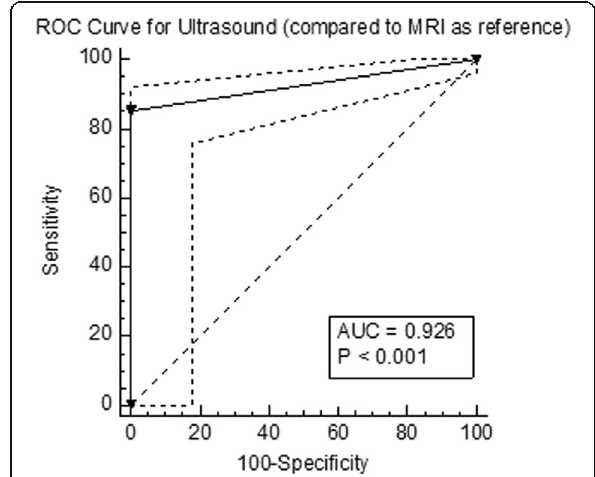
Fig. 4 ROC curve analysis of ultrasonography for the identification of anterior knee findings compared to MRI. ROC, receiver operating characteristic curve; MRI, magnetic resonance imaging; AUC, area under the curve